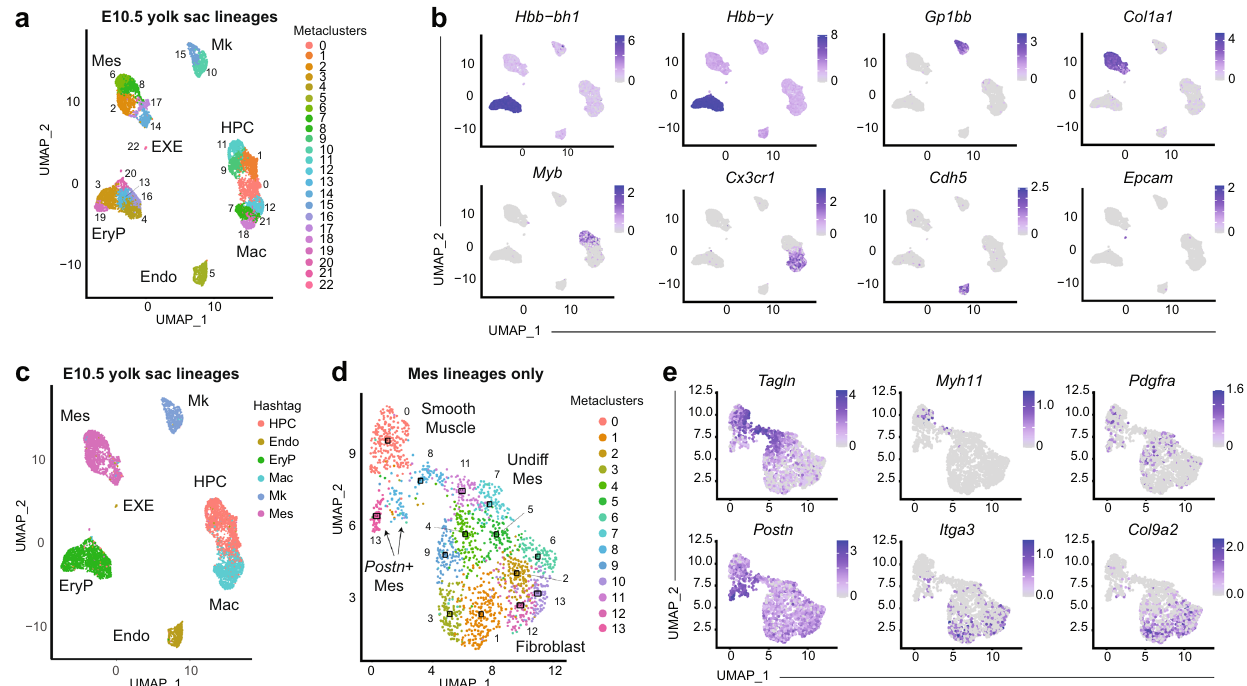
Fig. 5 | Characterisation of all E10.5 yolk sac mesoderm derivatives. a Seurat clustering of single cell RNAseq of yolk sac mesodermal populations: EryP (TER119+CD45 − ), Mk (TER119 − CD41+ CD45 − ), HPC (TER119 − CD41+ CD45+), Mac (TER119 − CD41 − CD45+), Endo (TER119 − CD41 − CD45 − CD31+), Mes (TER119 − CD41 − CD45 − CD31 − ). EXE, extraembryonic endoderm. b Representative marker genes for each of the metaclusters identi fi ed on ( a ). c Correspondance between population of origin and transcriptional identity in scRNA-Seq of yolk sac popula- tions. Each population was labelled with an individual barcode (hashtag) before